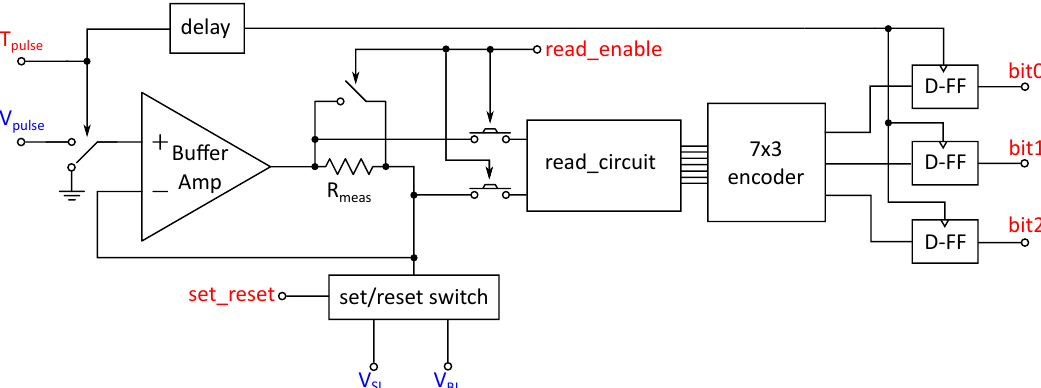
Figure 5. Overview of the circuit: Digital signals are marked red, while analog voltages are marked blue. The 1T1R cell is connected to the V BL and V SL terminals, where the corresponding voltages are applied. The switches are realized as transmission gates, the arrows signify the digital control signal of the transmission gate. The analog voltage level V pulse determines the height of the voltage pulse, while the length of the digital T pulse signal sets its length. The read_enable signal enables the read operation and connects or disconnects the read circuit, while the D flip-flops hold the output values bit0, bit1 and bit2 after the pulse is over and are triggered by the delayed T pulse